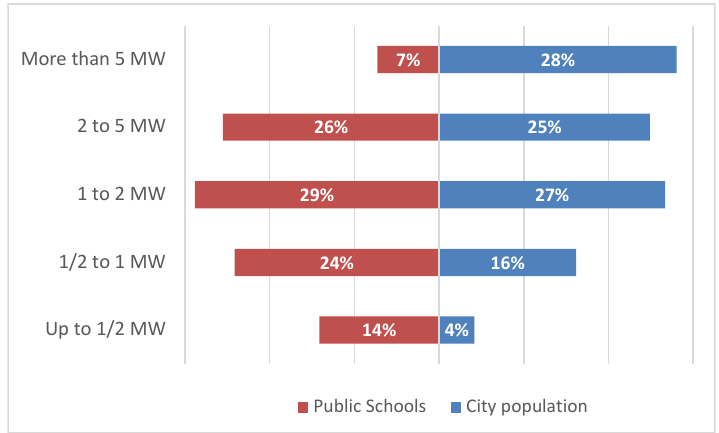
Figure 2. Comparison of family income of the public school students’ families and the city population of Vitória. Source: Authors using adapted data from [27].